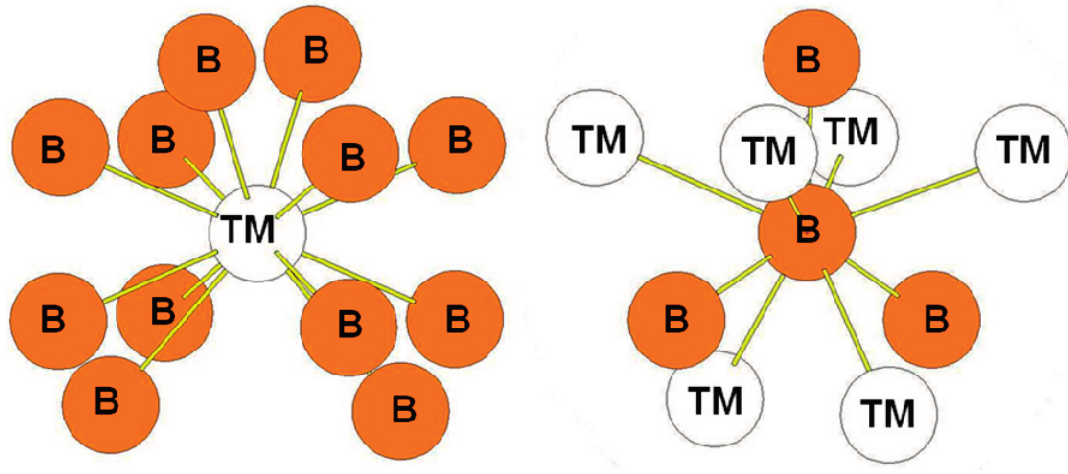
Figure 4. The environment of TM and B atoms in the tI12 ( α -ThSi 2 -type) structure. In the hR6 (hP18) structure (MoB 2 -type), the B atoms occupy two 2c Wyckoff positions (B1: 0.3322, 0.3322, 0.3322 and B2: 0.1815, 0.1815, 0.1815) while the transition metal atoms occupy other 2c positions (TM: 0.076, 0.076, 0.076) (see Figure 5a). The transition metal atoms are